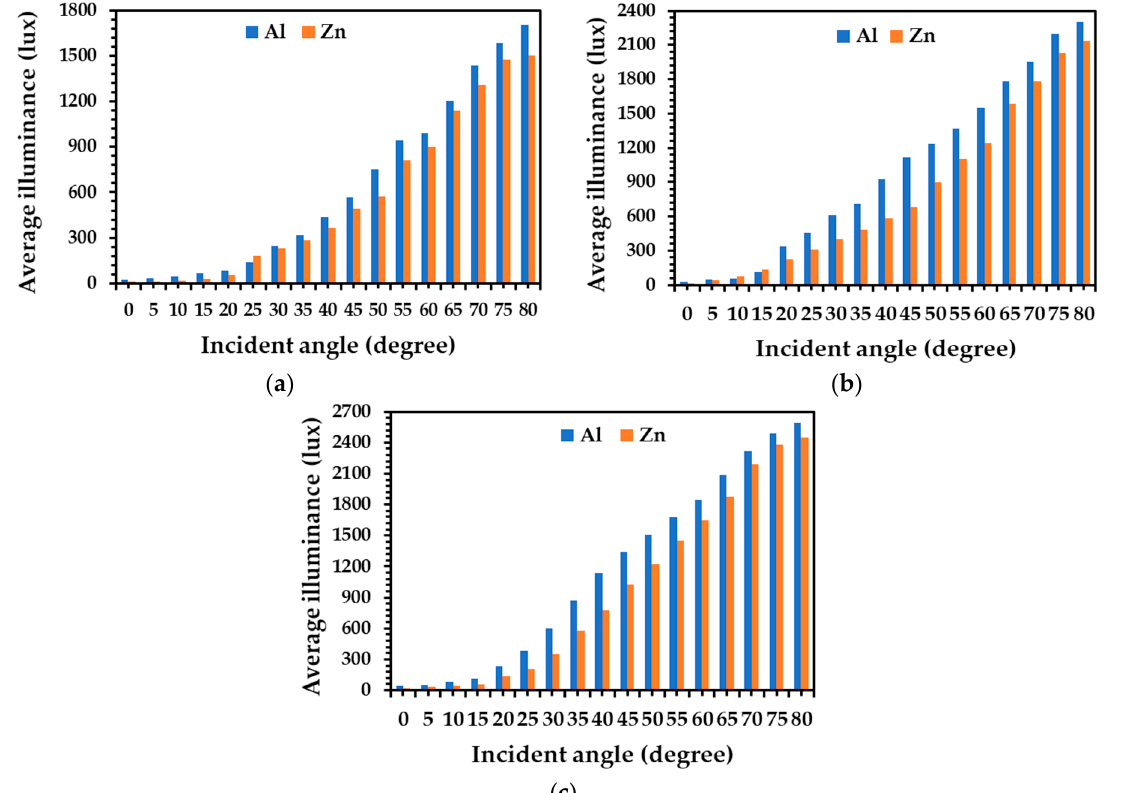
Figure 9. Average illuminance at the bottom end positions of aluminum alloy tube and zinc alloy tube with the diameters of ( a ) 0.20 m, ( b ) 0.25 m, and ( c ) 0.30 m.